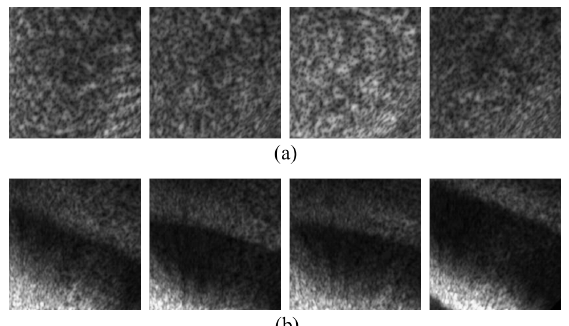
Figure 10. Sample images of ( a ) TDI-2017 and ( b ) TDI-2018 that failed to be classified into the label of background.